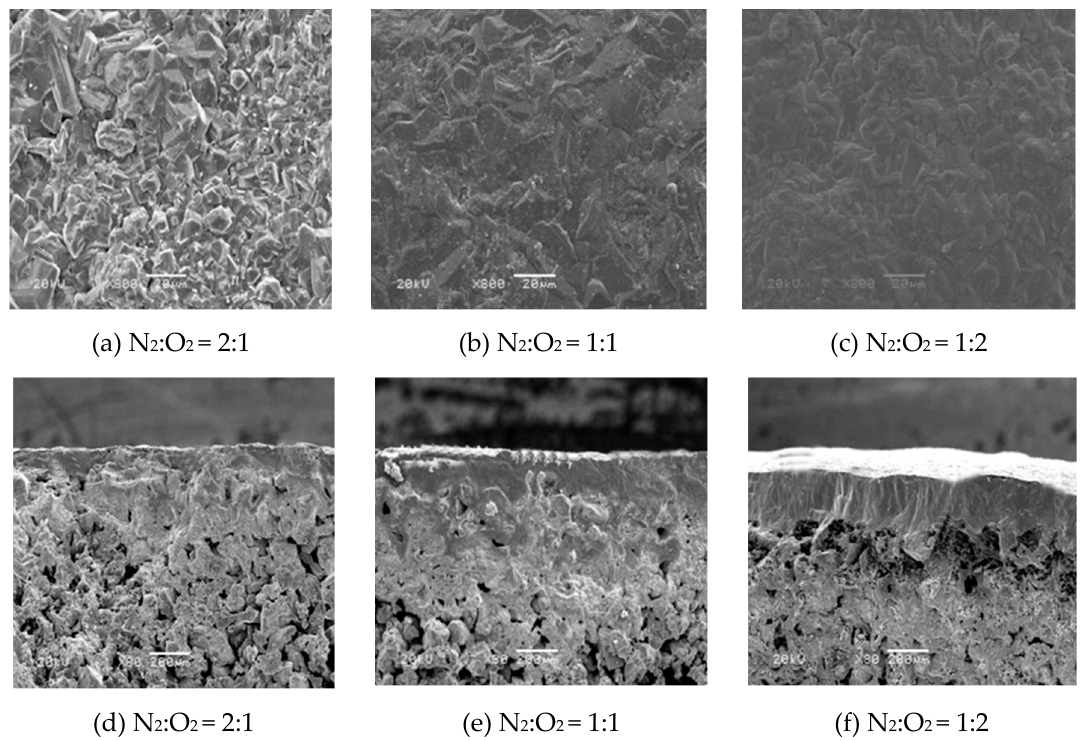
Figure 4. Surface and cross-section morphology of Ti support after oxidation at 800 °C for 60 min, at different oxygen concentrations.